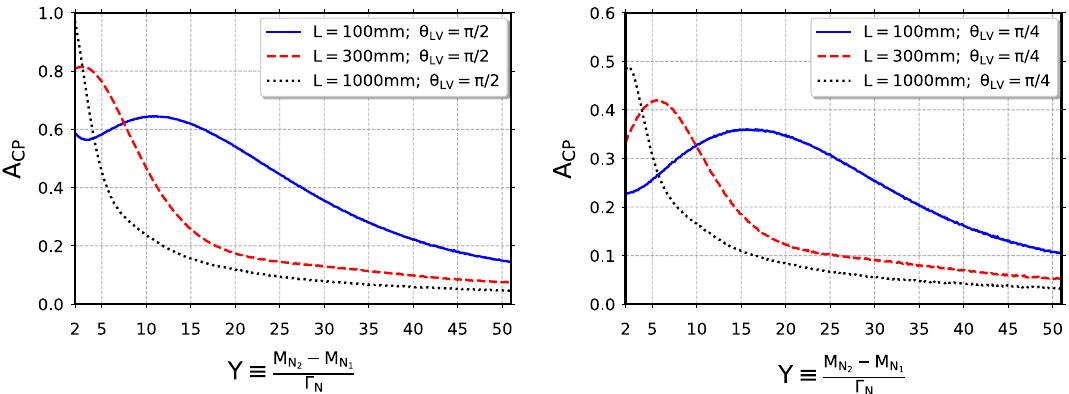
Fig. 7 CP asymmetry as a function of Y for M N = 2 . 0 GeV and | B μ N | 2 = | B τ N | 2 = 10 − 5 . Left Panel: θ LV = π/ 2. Right panel: θ LV = π/